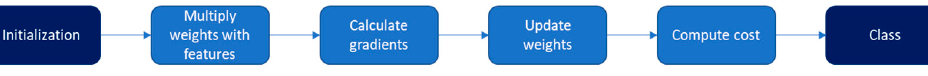
Figure 5. Indicative example of LR steps.